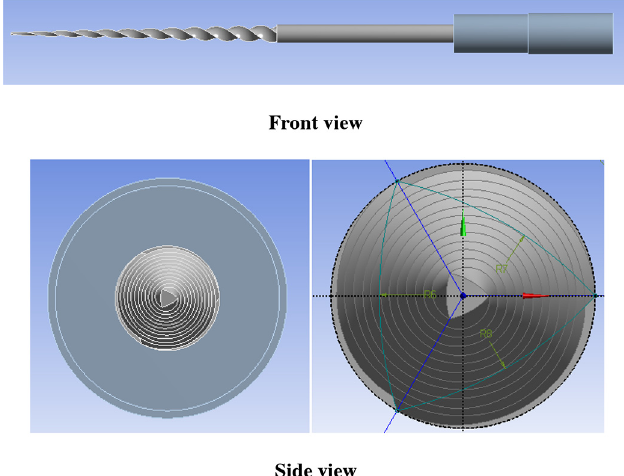
Fig. 2. CAD model of hyplex CM endodontic